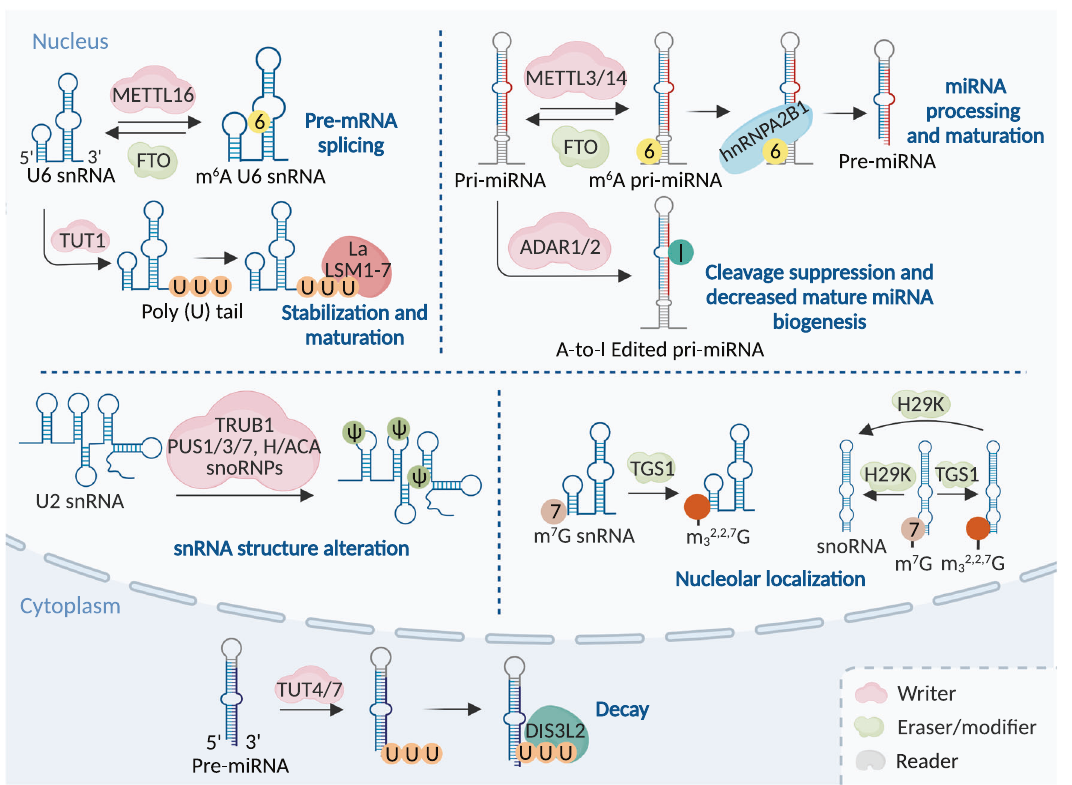
Fig. 4 The machinery of RNA modi fi cations and their molecular functions in snRNA, snoRNA and miRNA. The indicated RNA modi fi cations are installed on snRNA, snoRNA and miRNA through respective writers. m 6 A modi fi cations on snRNA and miRNA can be removed by FTO, while m 7 G modi fi cations on snRNA and snoRNA can be removed by H29K, making RNA modi fi cations on snRNAs, snoRNA or miRNAs dynamically reversible process. Besides, m 7 G installed snRNA and snoRNA can be further modi fi ed as m 2,2,7 G by modi fi er TGS1. RNA modi fi cations affect the function of these non-coding RNAs via altering their structures, facilitating fi ne-tuning in various physiological processes. m 6 A N 6 - methyladenosine; m 7 G 7-methylguanosine, ψ pseudouridine, U Uridine, A-to-I adenosine-to-inosine, m 32,2,7 G 2,2,7-trimethyl guanosine, pri- miRNA primary microRNA, pre-miRNA precursor